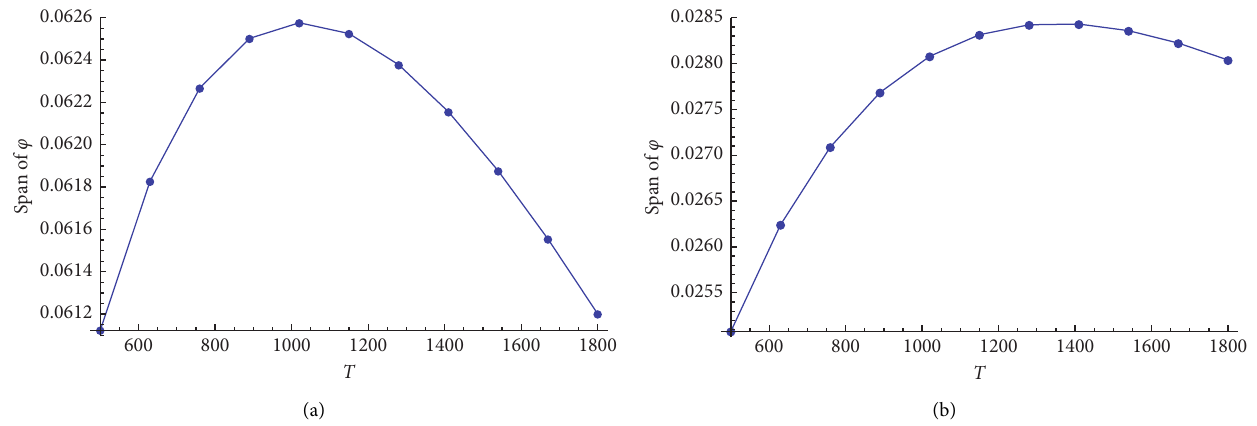
Figure 5: Change in span of ϕ with T : (a) case without fairness concerns; (b) case with fairness concerns.